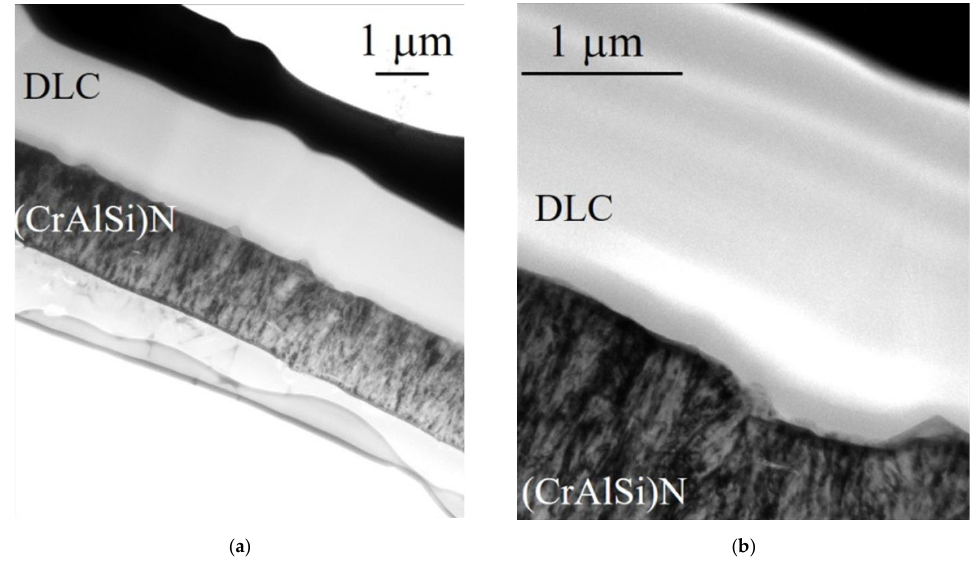
Figure 11. Microstructure of (CrAlSi)N/DLC coating formed on SiAlON ceramic inserts: ( a ) general view; ( b ) layer and sublayer.